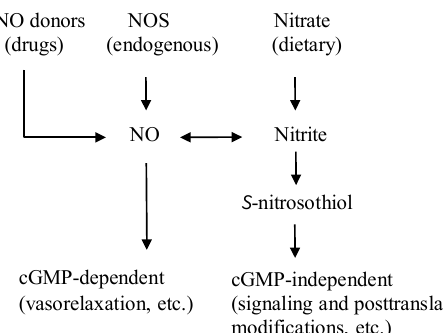
Figure 1. The NO pathways. NO is originated from the diet, drugs, and the endogenous NOS enzyme. The activities of NO are exerted through cGMP-dependent and independent ways. NO donor drugs, such as nitroglycerin and sodium nitroprusside, directly release NO. NOS endogenously generates NO, which is linked to the cGMP-dependent functions of NO. mainly for